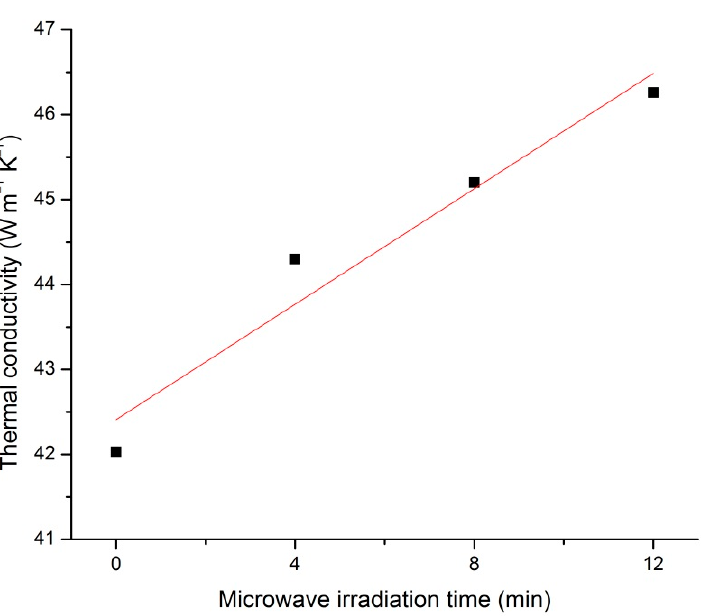
Figure 10. Thermal conductivity of the ZnO-nanorod-coated fabrics for different microwave irradiation times.